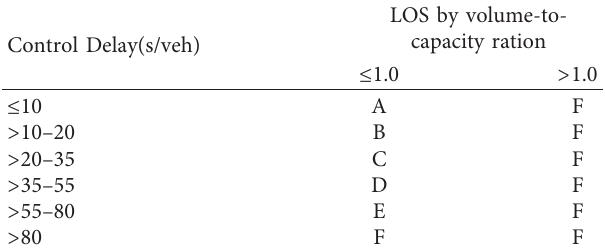
Table 1: LOS criteria